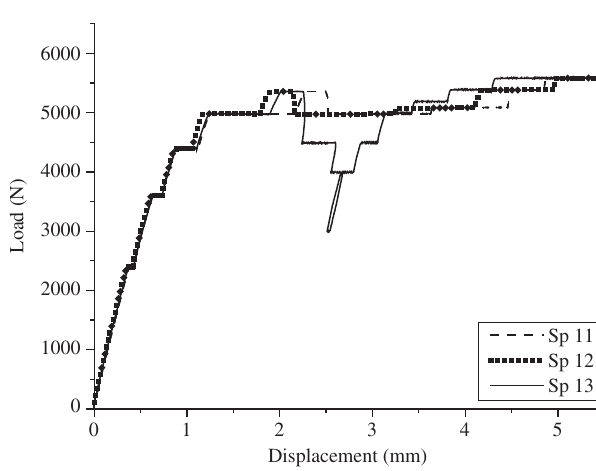
Figure 2. Load-displacement with creep cycles. Loading, unloading and re-loading cycles.